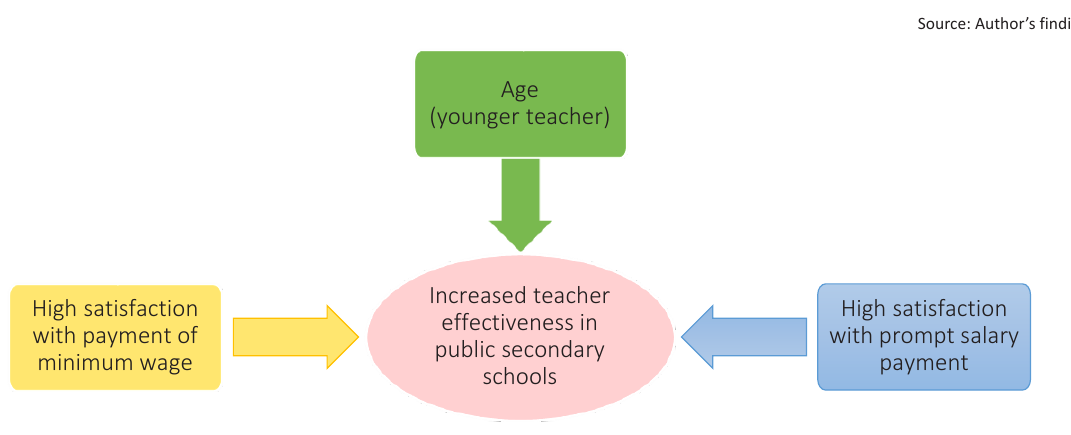
Figure 1. Empirical model of increasing teacher effectiveness in public secondary